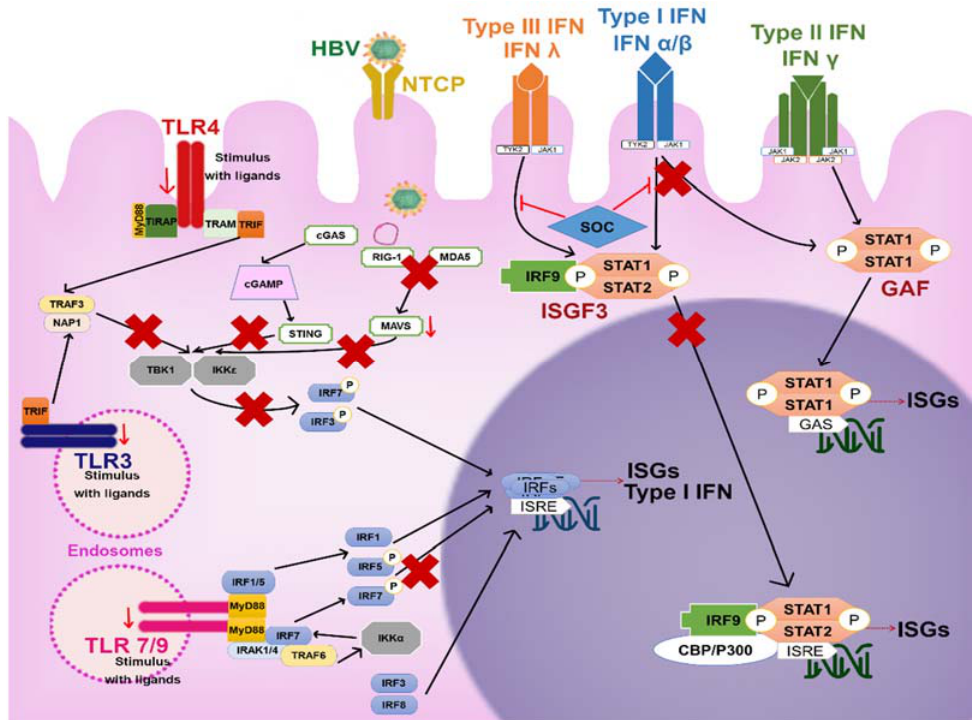
Figure 6. Probable signaling in the mechanism induced by TLRs, IFNRs, RIG-I, and STING in the control of the viral infection and how the virus interferes with them (marked with a red X). The stimulus of TLRs can induce a response to eliminate HBV. HBV presence leads to downregulation of the expression of TLRs (observed in PBMCs; indicated with red arrows) and/or interfere with its signaling (blocking the MyD88-IRAK4 axis, suppressing IRF3 activation, inhibiting the expression and nuclear translocation of IFR7). The virus can also inhibit RIG-I/MDA5-mediated response and STING- stimulated IRF3 activation; blocks: the activation of interferon IRF3 and IRF7, TBK1/IKK ε activation, STING-stimulated IRF3 activation and, down-regulate the expression of MAVS. The presence of the virus can also interfere with IFN receptors signaling by avoiding nuclear translocations of